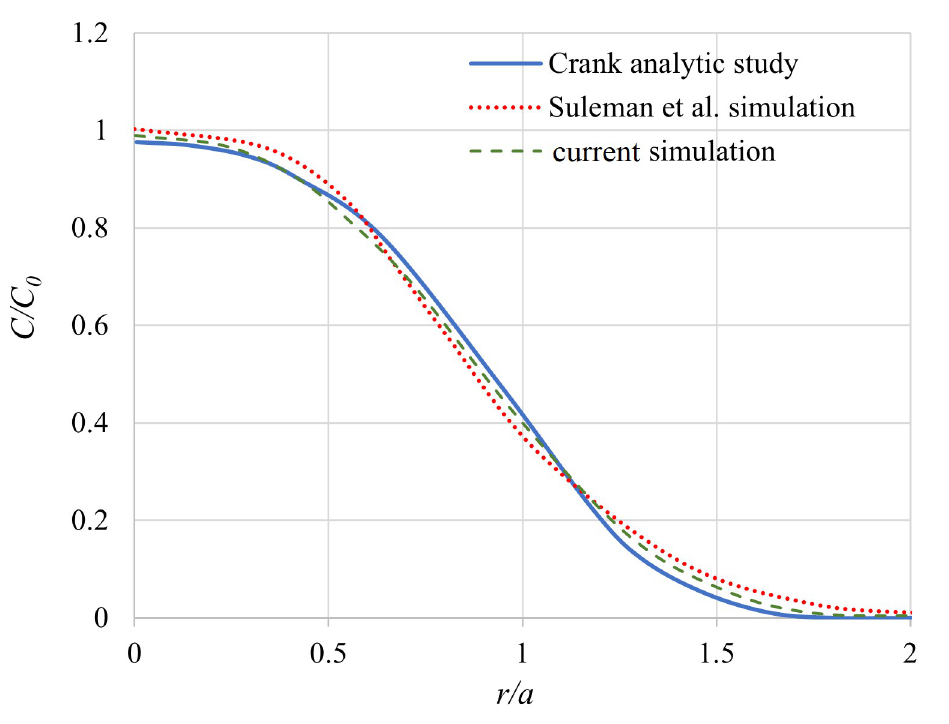
Fig 10. Comparison among current simulation, Suleman et al. simulation, and Crank analytic study plots of concentration distribution for a spherical source with uniformly initial concentration distribution.